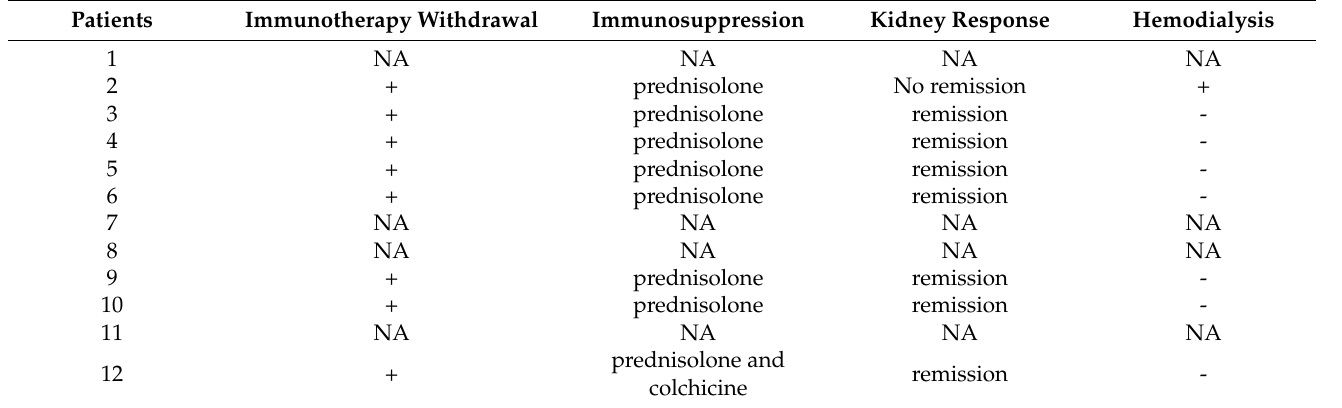
Table 5. The table summarizes the therapeutic approach of patients’ immune-mediated kidney toxicity and their response to treatment. Yes: +, No: